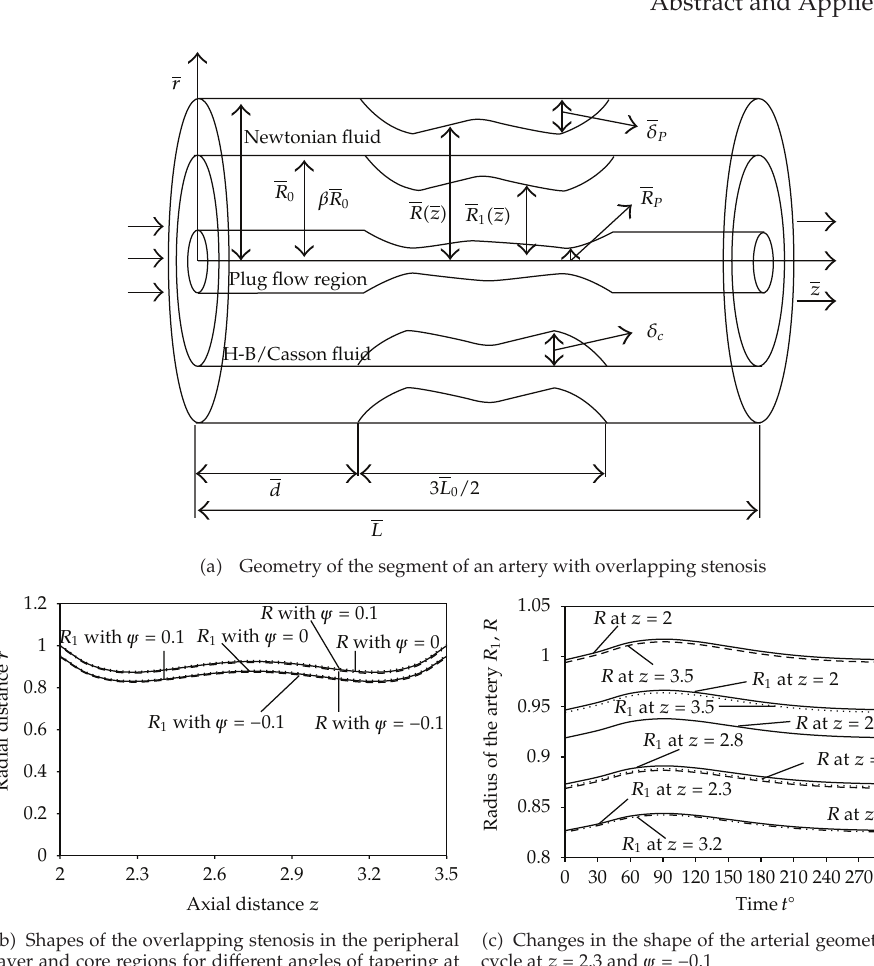
Figure 1: Pictorial description of segment of the artery with overlapping